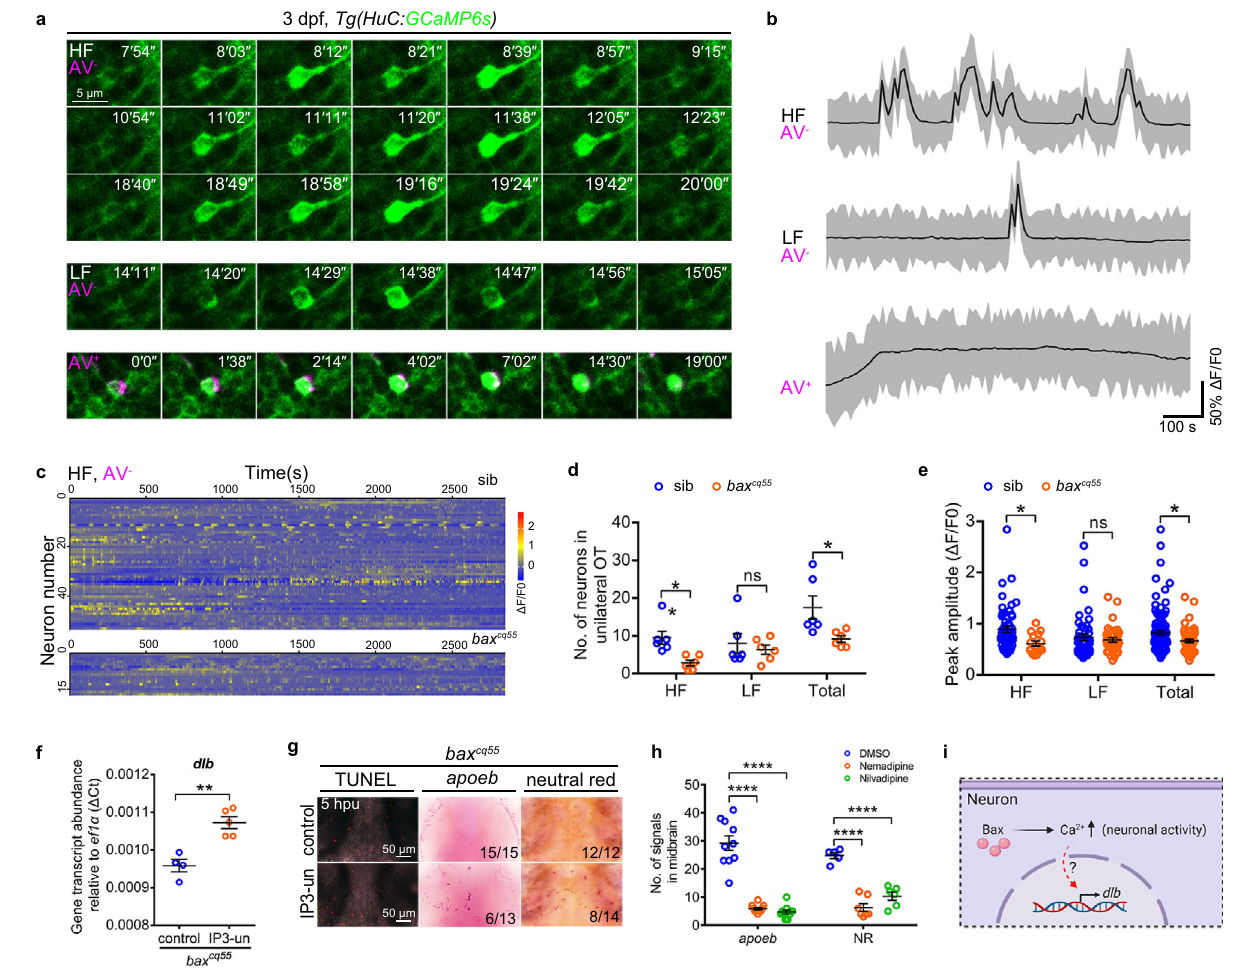
Fig. 5 | Bax drives dlb expression via a special type of neuronal activities. a Confocaltime-lapseimagingofGCaMP6s + signals(green)inHF(top),LF(middle) andAV + apoptoticneurons(bottom,magenta)inthemidbrains.Thenumberinthe up-rightcornerindicatedthetimepointes. b RepresentativepatternsofCa 2+ events intheHF,LF,andAV + neuronsduring1000secondsofimaging. c GCaMP6s + traces ofHFneuronsintheunilateralmidbrainsof3dpfsiblingsand bax cq55 mutants( n =6 per group). d The number of HF, LF, and total active neurons in the unilateral midbrainsof3dpfsiblingsand bax cq55 mutants.Eachdotdenotesone fi sh( n =6per group). e Quanti fi cationofthepeakamplitudeofcalciumevents( Δ F/F0)ofHF,LF, and total calcium events in the unilateral midbrains of 3 dpf siblings and bax cq55 mutants ( n =6 fi sh in each group). Each dot denotes one calcium event. f qPCR resultofthe dlb transcriptionallevelat5hpu.Thedataarefromthreeindependent